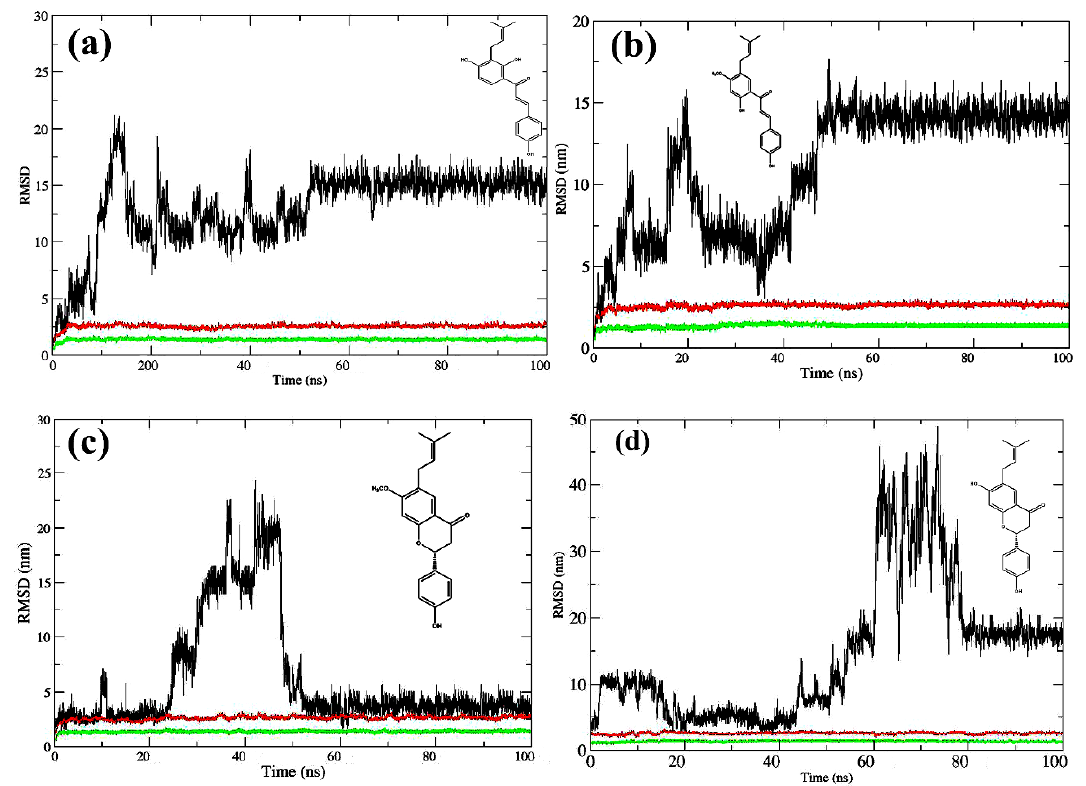
Figure 5. Root mean square deviation (RMSD) in molecular dynamics (MD) simulations of A β 42 peptide complex with compound 1 ( a ), compound 2 ( b ), compound 3 ( c ) or compound 4 ( d ). RMSD of protein backbones (green lines), proteins with all atoms (red lines), and ligands (black